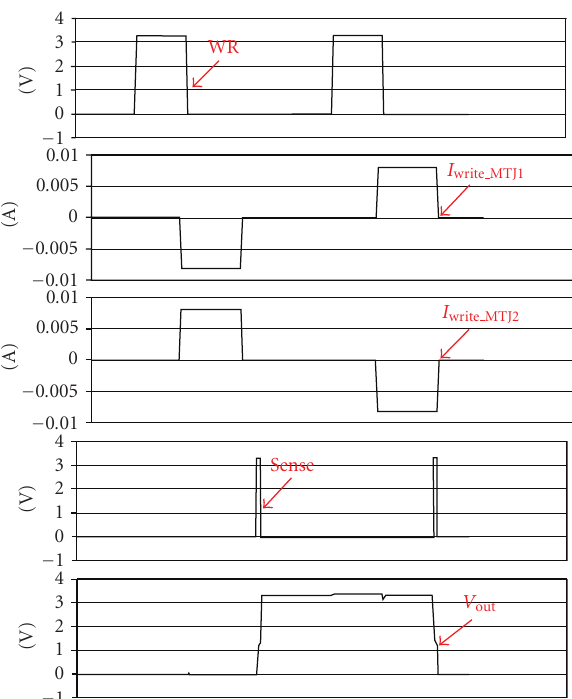
Figure 12: Simulation results obtained from the first structure of the TAS-MRAM in 0.35 μ m CMOS combined with the TAS- MTJ technology, under a supply voltage V dd = 3 . 3 V. The signal “WR” represents the signal called “write/read” as shown in the TAS-MRAM cell (see Figure 5). The signals I write MTJ1 and I write MTJ2 are the write current pulses applied to the MTJ1 and the MTJ2, respectively.